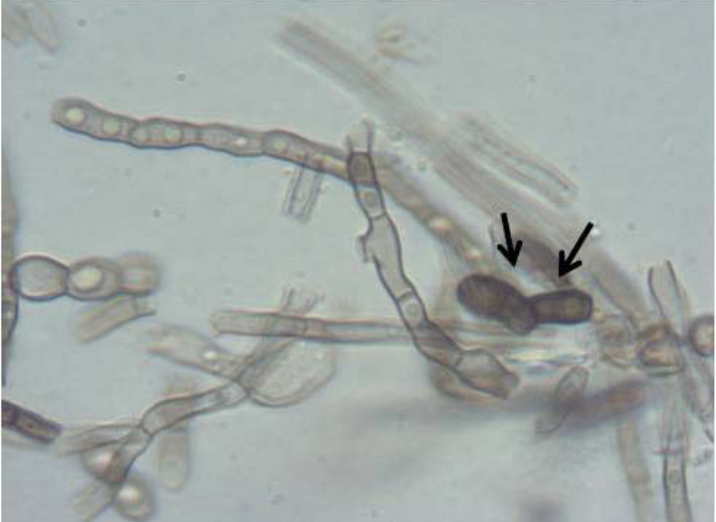
Figure 2 . Highly melanized hyphal cells from F. pedrosoi cultured for six months